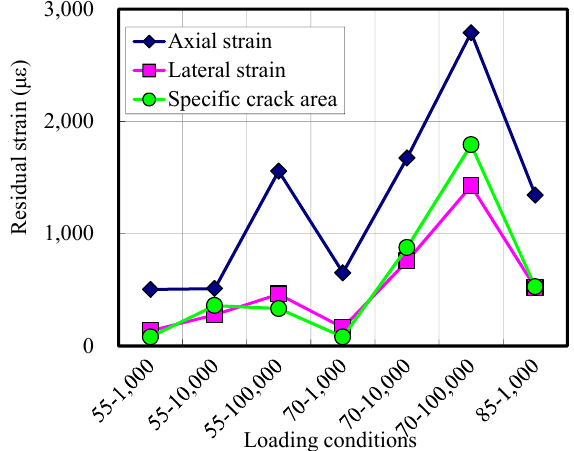
Figure 8. Residual strain and specific crack areas after the loads are applied.